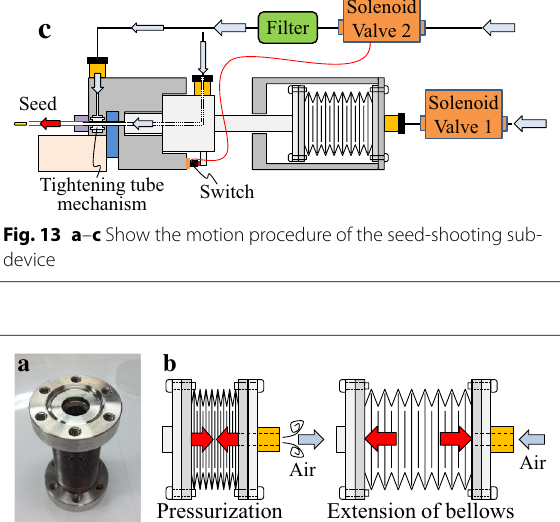
Fig. 11 Mechanism of the seed-setting sub-device front view (left column) and side view (right column). a – d show the motion proce- dure